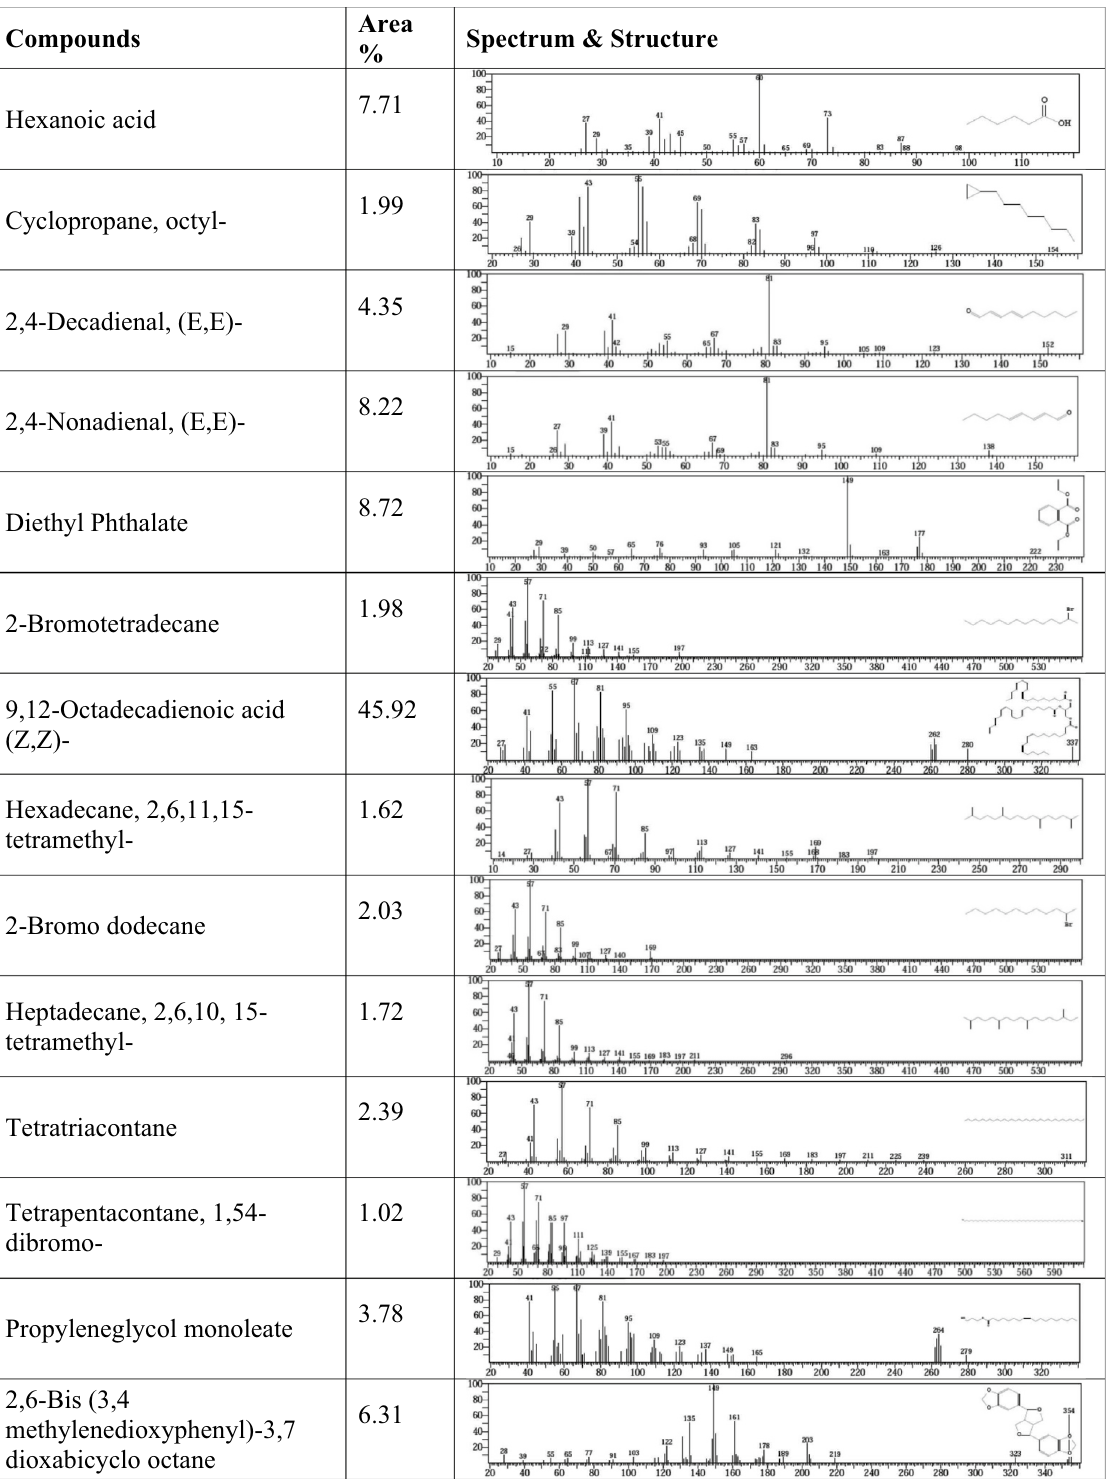
Figure 9. GC–MS analysis of lipids produced by Scenedesmus obliquus before methyl red